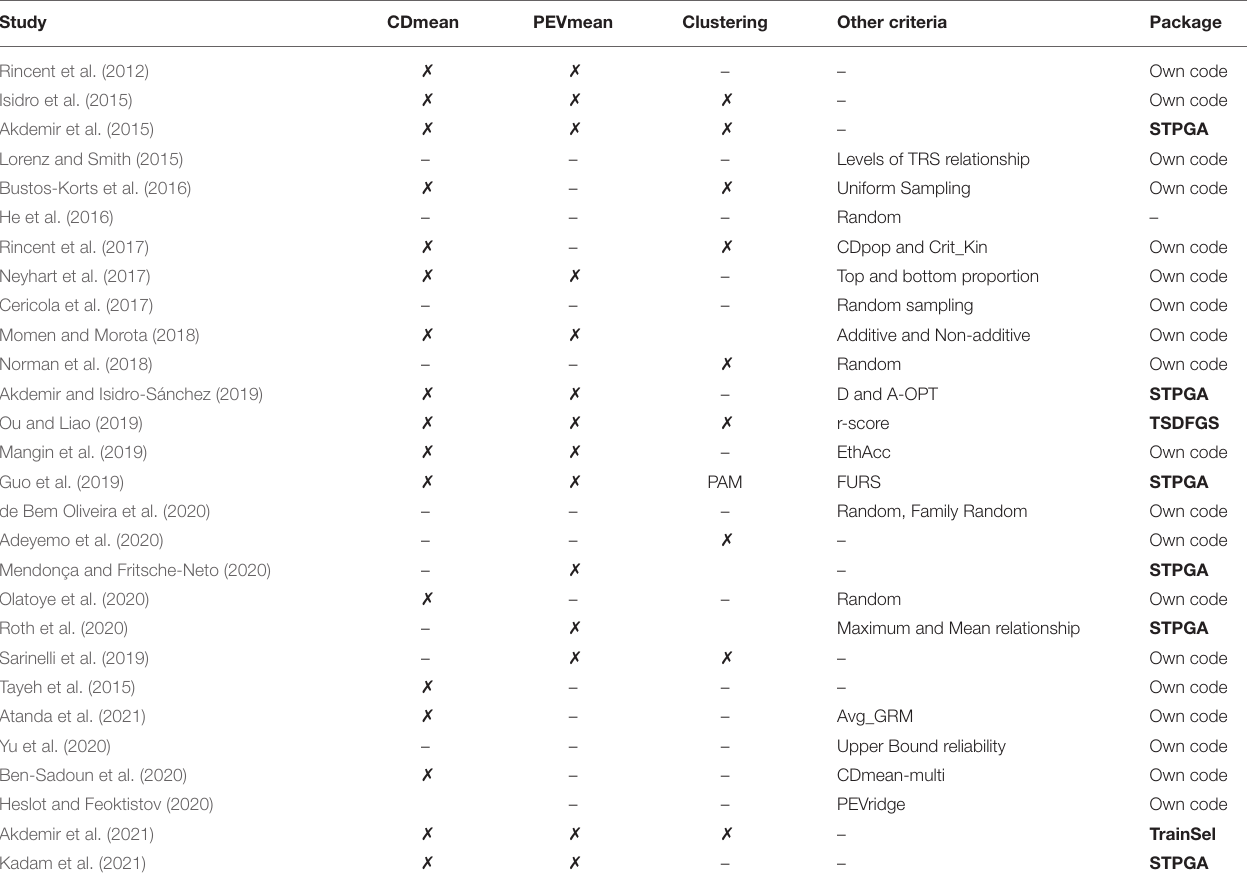
TABLE 1 | Key relevant scientific studies on training set (TRS)